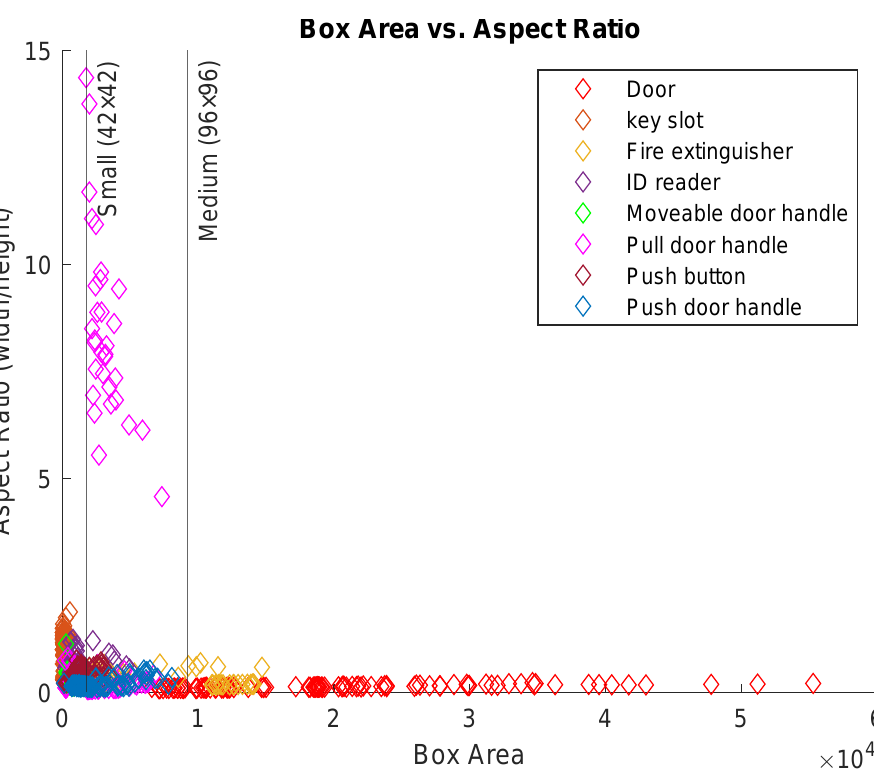
Figure 1. Sizes and aspect ratios of objects in the detection